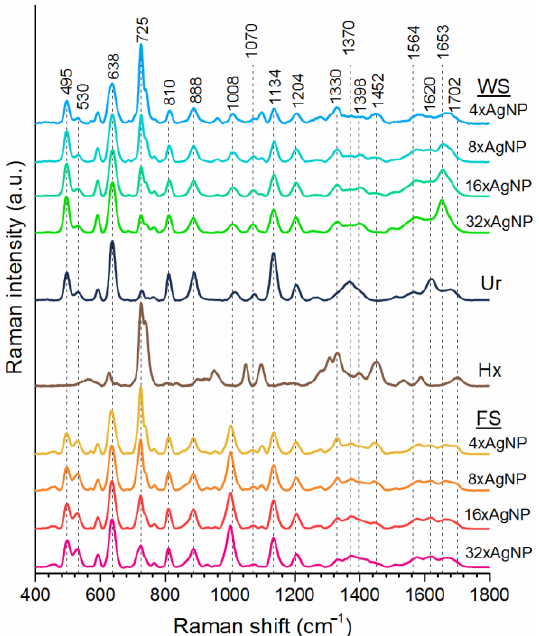
Figure 2. Comparison of SERS spectra for uric acid (Ur), hypoxanthine (Hx), whole serum (WS) and filtered serum (FS) with increasing AgNP concentrations.